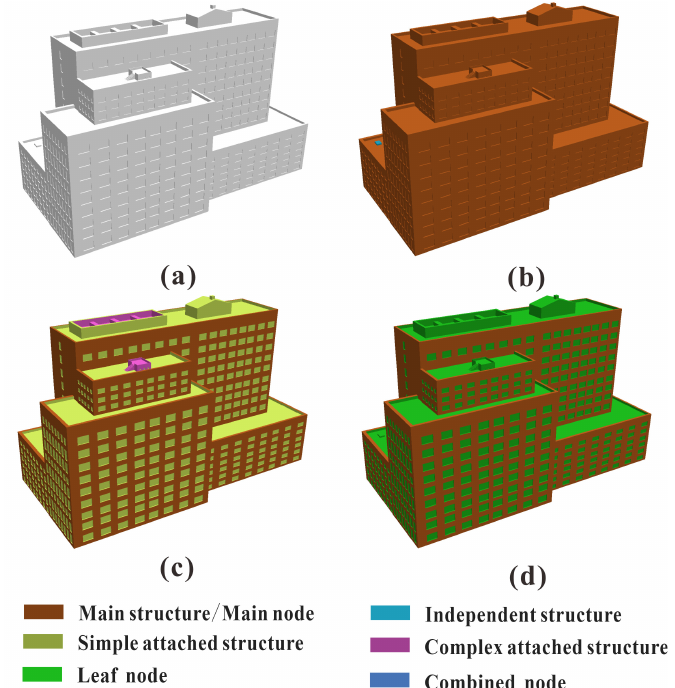
Figure 11. Structure extraction and transmission node construction results of Model 2. ( a ) Original model, ( b ) independent structure extraction results, ( c ) attached structure extraction results and ( d ) transmission node construction results.